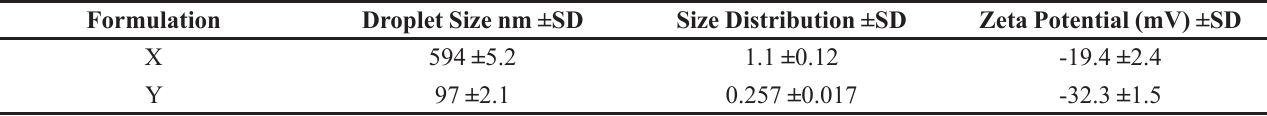
TABLE III - Mean droplet size, size distribution, and zeta potential of formulations X and Y Formulation